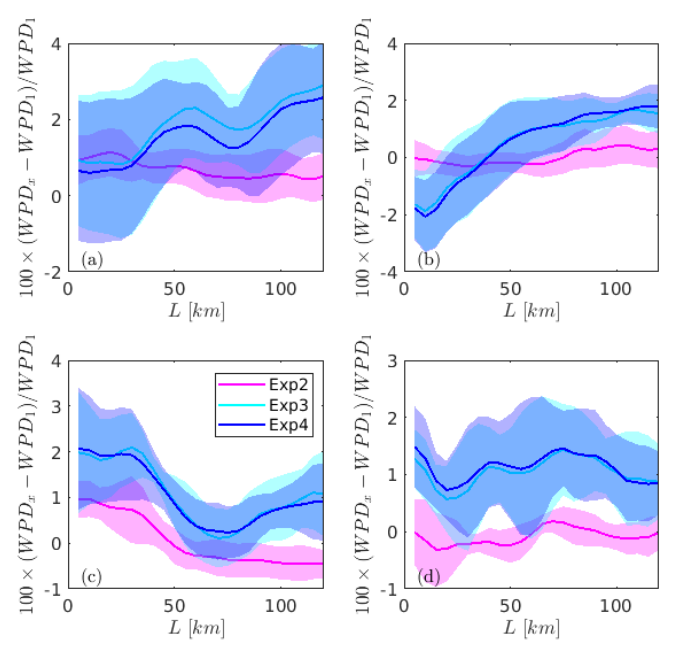
Figure 10. The relative difference of WPD between the sensitivity experiments (i.e., Exp2, Exp3, and Exp4) and Exp1 for the four chosen areas: ( a ) A, ( b ) B, ( c ) C and ( d ) D in January 2015. The shaded areas represent the standard deviation.